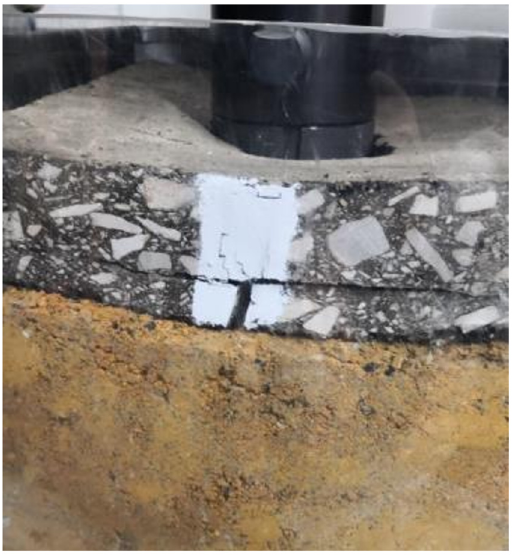
Figure 11. Failure mechanism after testing the specimen with the granular base as a support.